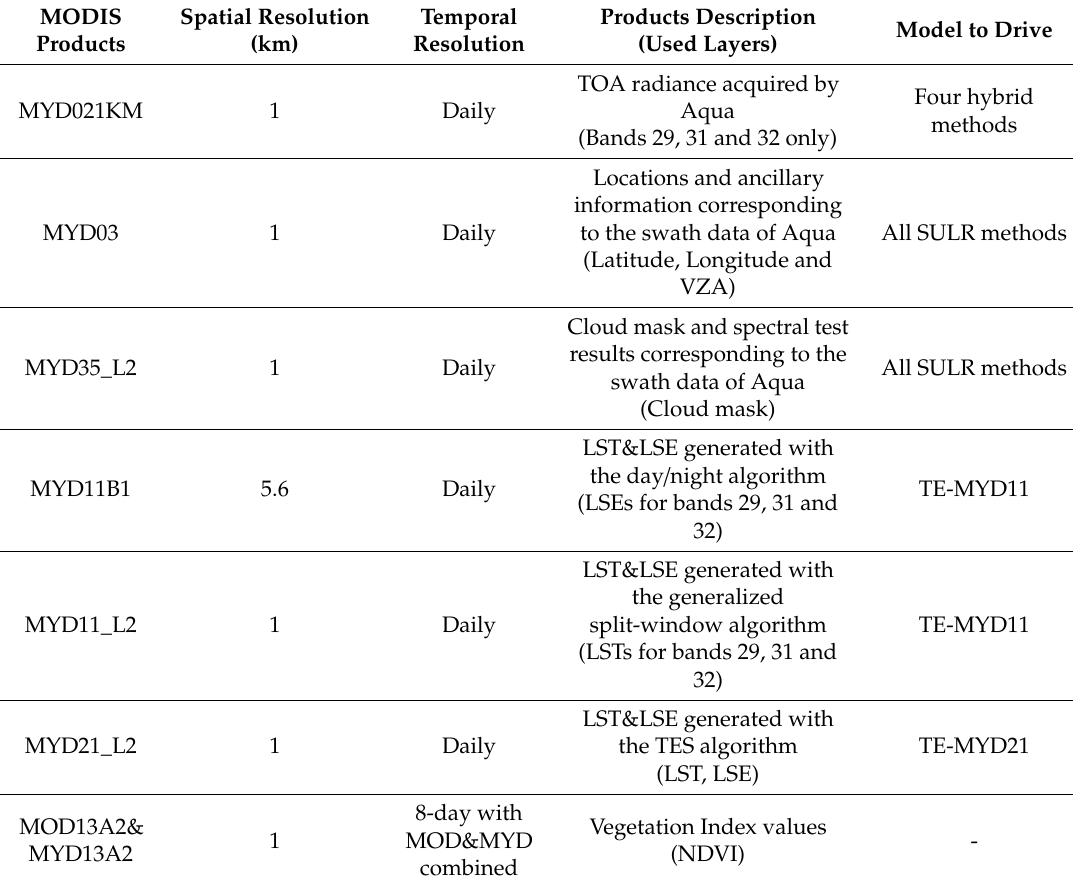
Table 1. List of the MODIS products used in this